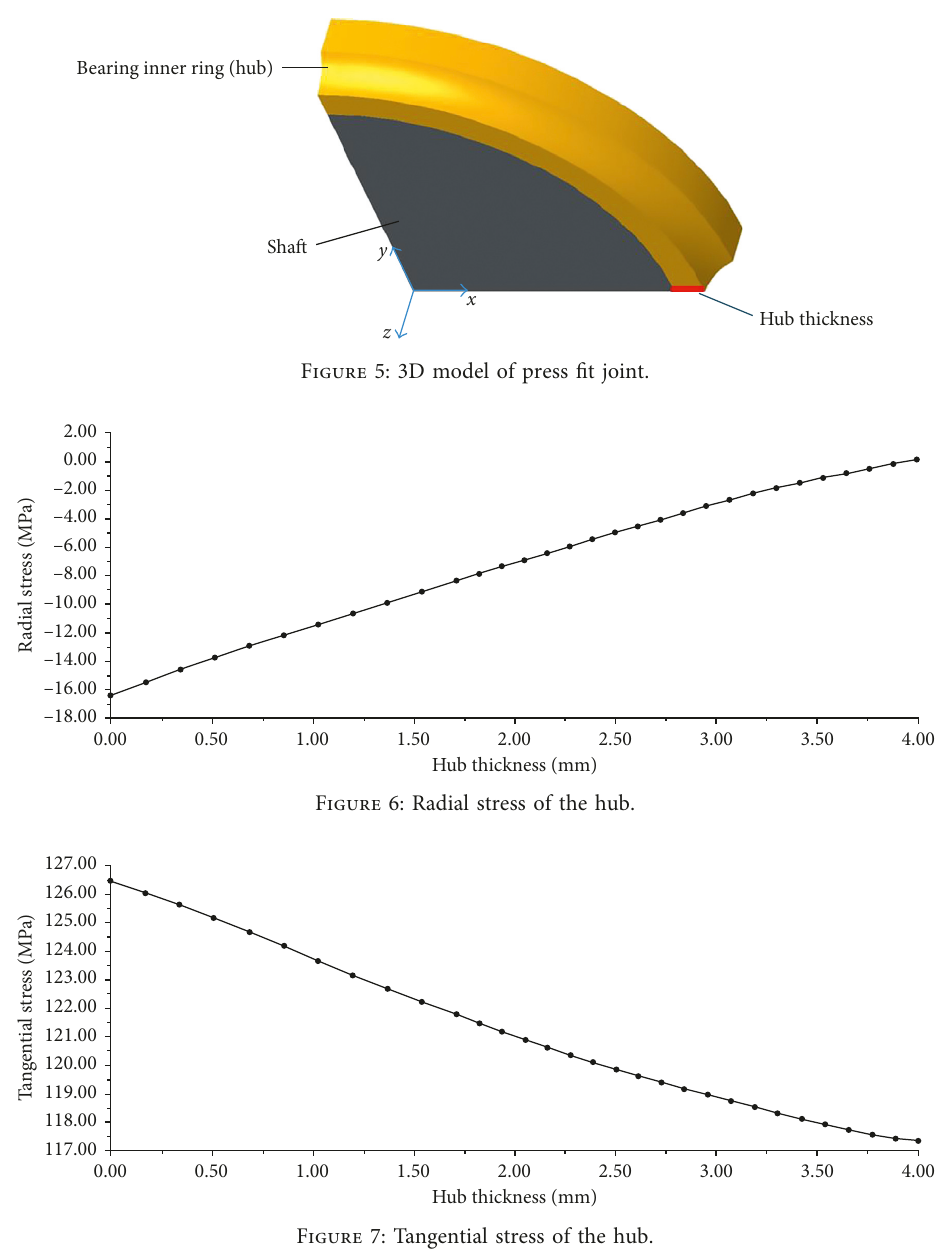
Figure 7: Tangential stress of the